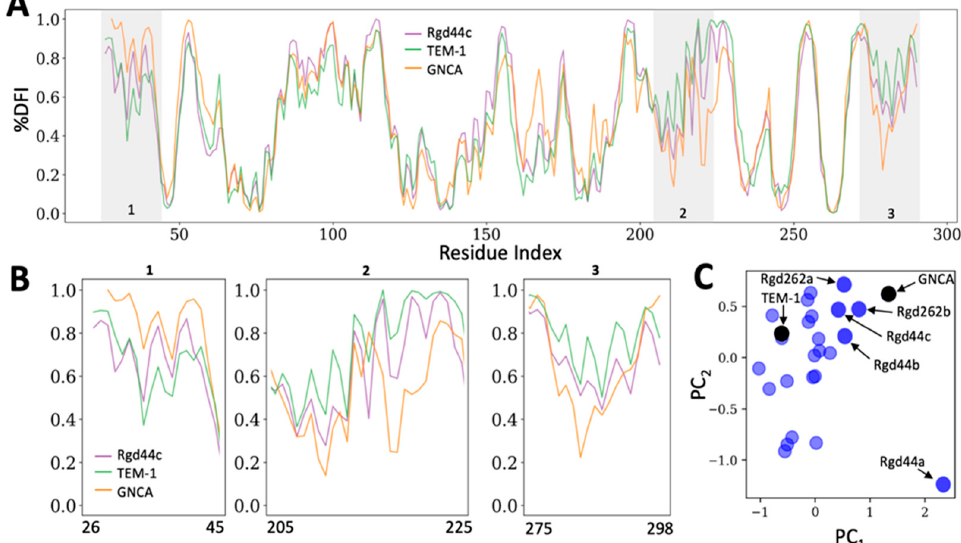
Figure 4. Dynamic analyses of TEM-1, GNCA, and the rigid designs. ( A ) Depiction of the dfi profile of TEM-1 (green), GNCA (orange) and variant Rgd44c (purple); Rdg44c is chosen as an example for illustrative purposes. ( B ) Portions of the full dfi profile of each protein ( A ) are expanded to highlight dynamic differences between the three proteins. A shift towards a GNCA-like dfi profile is an indication of a change in dynamical characteristics of a protein. ( C ) Principal Component Analysis (PCA) of the rigid designs. The first (x-axis) and second (y-axis) principal components have weights of 3.5 and 2.7, respectively. Designs chosen for experimental characterization are highlighted using darker colors and labeled with the design name.